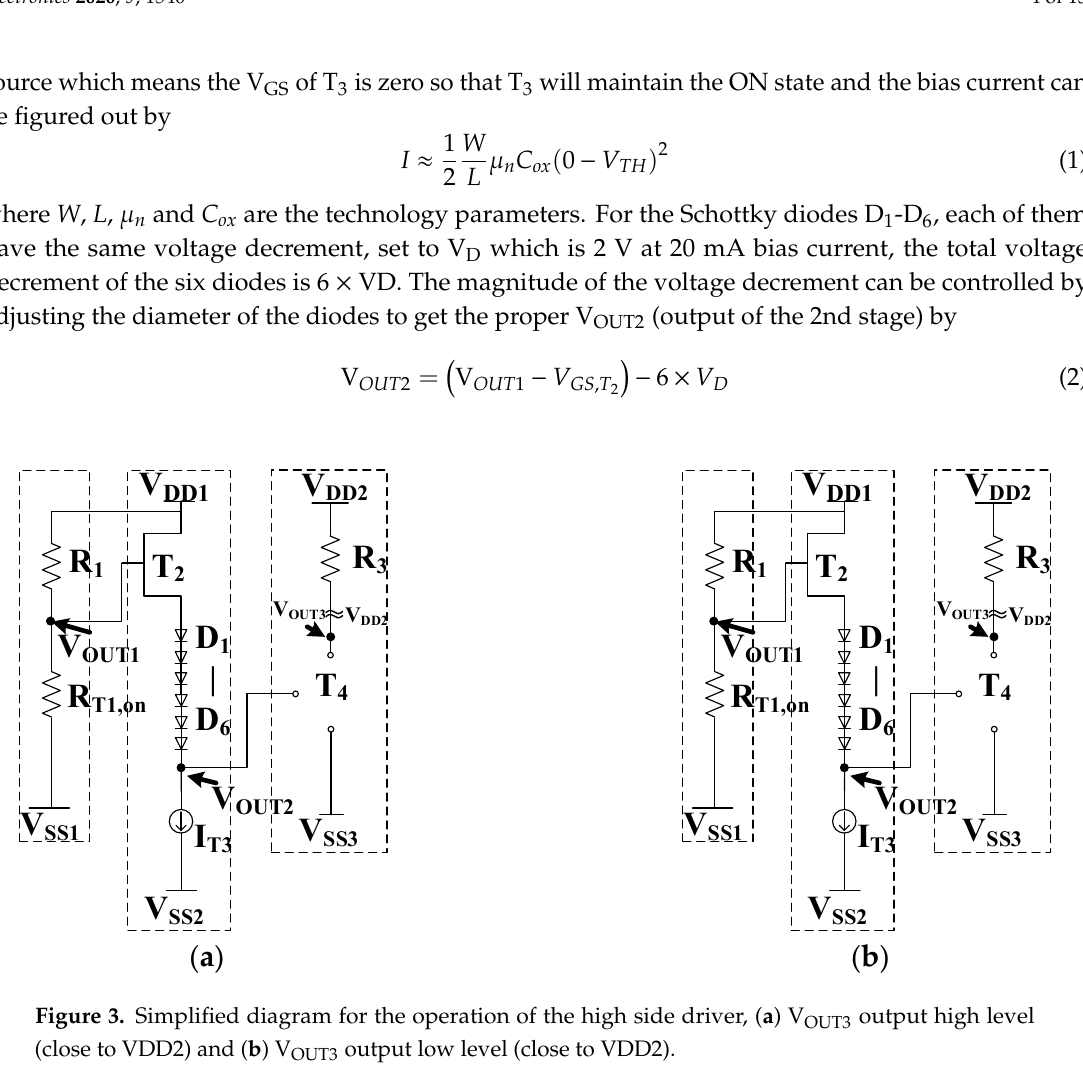
250 Ω for R 4 in the other side. The simulated output waveforms of both side with di ff erent resistors are shown in Figure 4b,c. After confirming the value of all the resistors, the simulated optimized results for driver are shown in Figure 5 proving that the demonstrated gate driver can satisfy the demand for a high swing of the high side power transistor T HS at 200 MHz, not to mention T LS